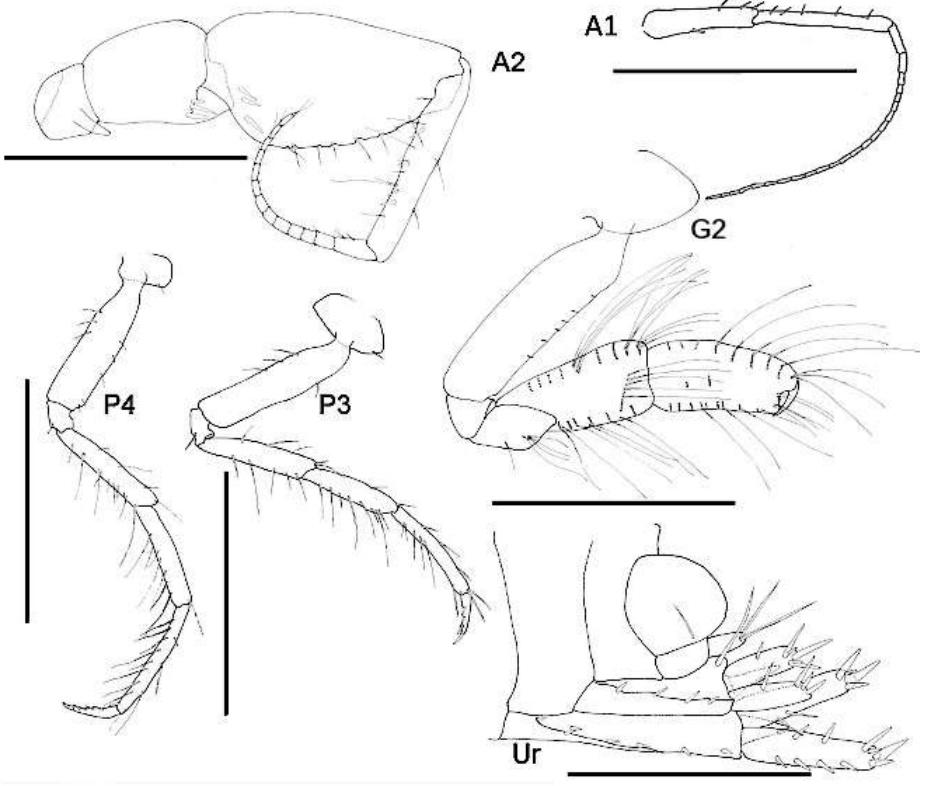
Figure 12. Unciola icelandica sp. nov. holotype male, 11 mm, SMF 52167, North Shetland Islands, 169 m. Scale: 0.5 mm.